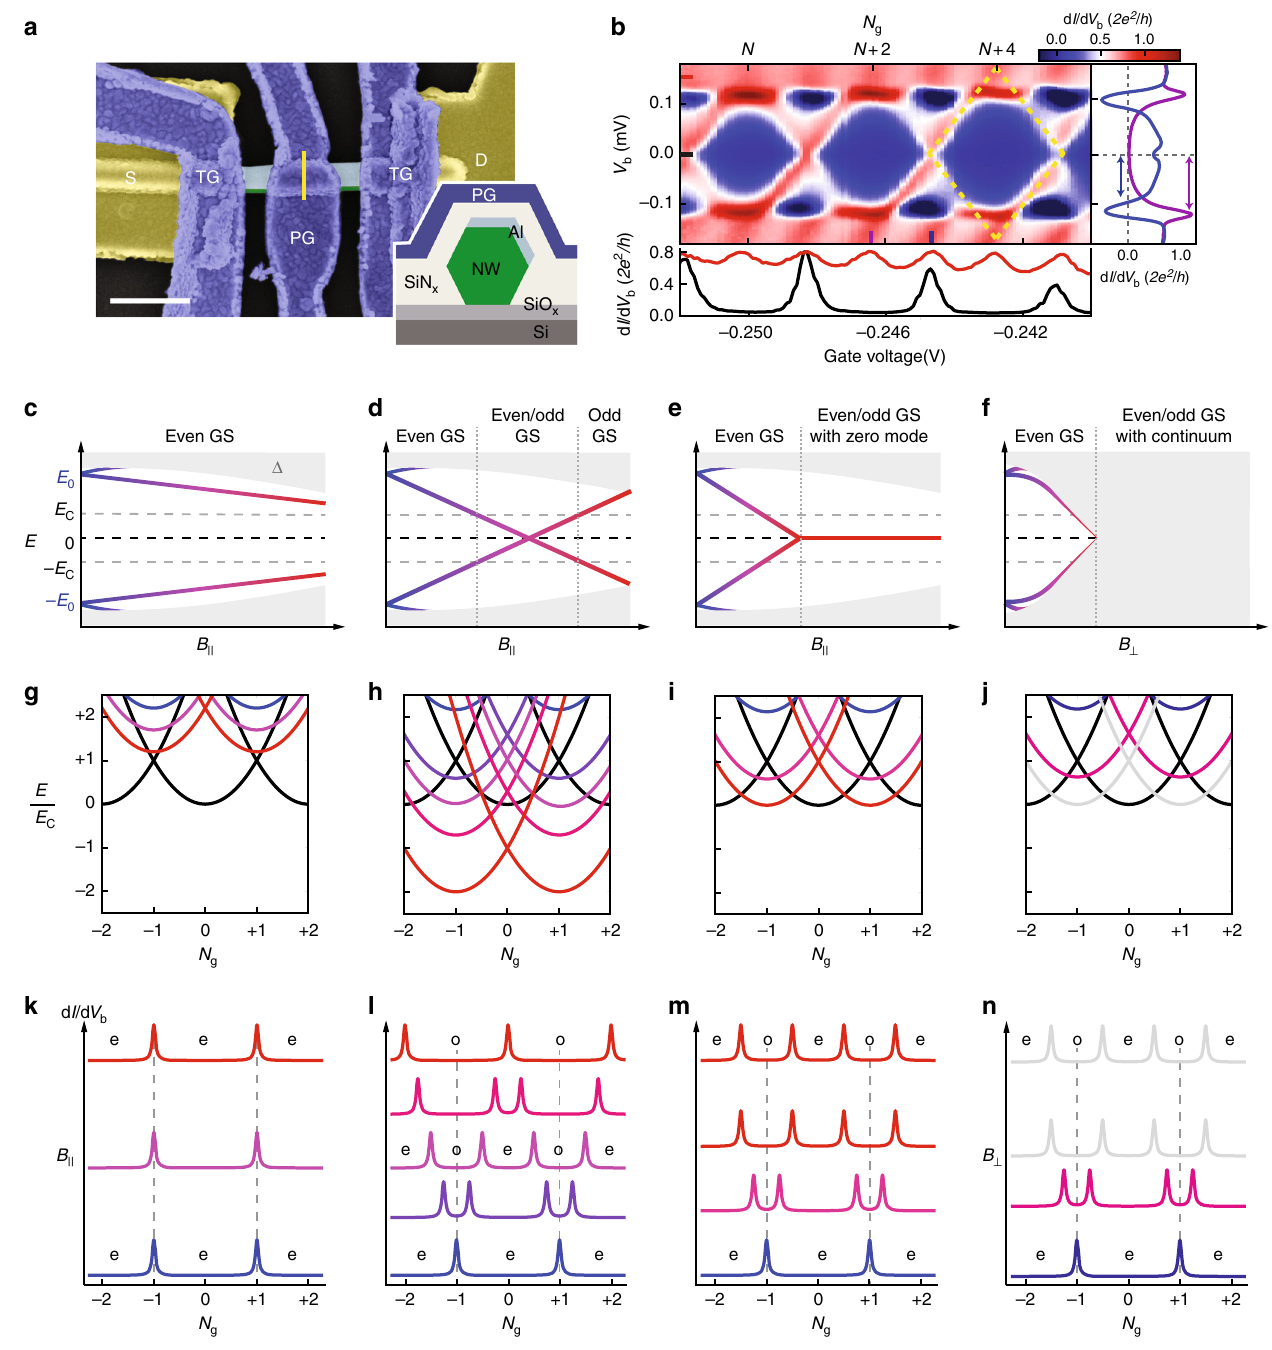
peaks with equal heights 22 . Here, G e → o ( G o → e ) is the peak height at 2 e -periodic oscillations, but strikingly with an odd-parity in the valleys (cf. Fig. 1l). The parity transition is also illustrated in an even-to-odd (odd-to-even) transition occurring upon increas- Fig. 2f by the single crossing between S e and S o . Similar to Fig. 2a, ing V PG . Fig. 2g shows that Λ undergoes drastic oscillations above 0.9 T the oscillation becomes 1 e -periodic (see linecuts). around 0.5 as B ∥ is varied, and levels off at 0.5 above 0.9 T. The data in Fig. 2d are taken for the same gate con fi guration as Fig. 2c but in a perpendicular B- fi eld, which turns the Al into a normal state around B ⊥ = 0.18 T (see also Supplementary Fig. 3). In the normal state the oscillations are 1 e -periodic and both Λ and S e / S o are constant, in agreement with established expectations 6 . The four columns in Figs. 1 and 2 represent distinct phases at G e ! o high B : an even-parity GS, an odd-parity GS, a superconducting , which amounts to 0.5 for G e ! o þ G o ! e phase of alternating even and odd parities due to a single state